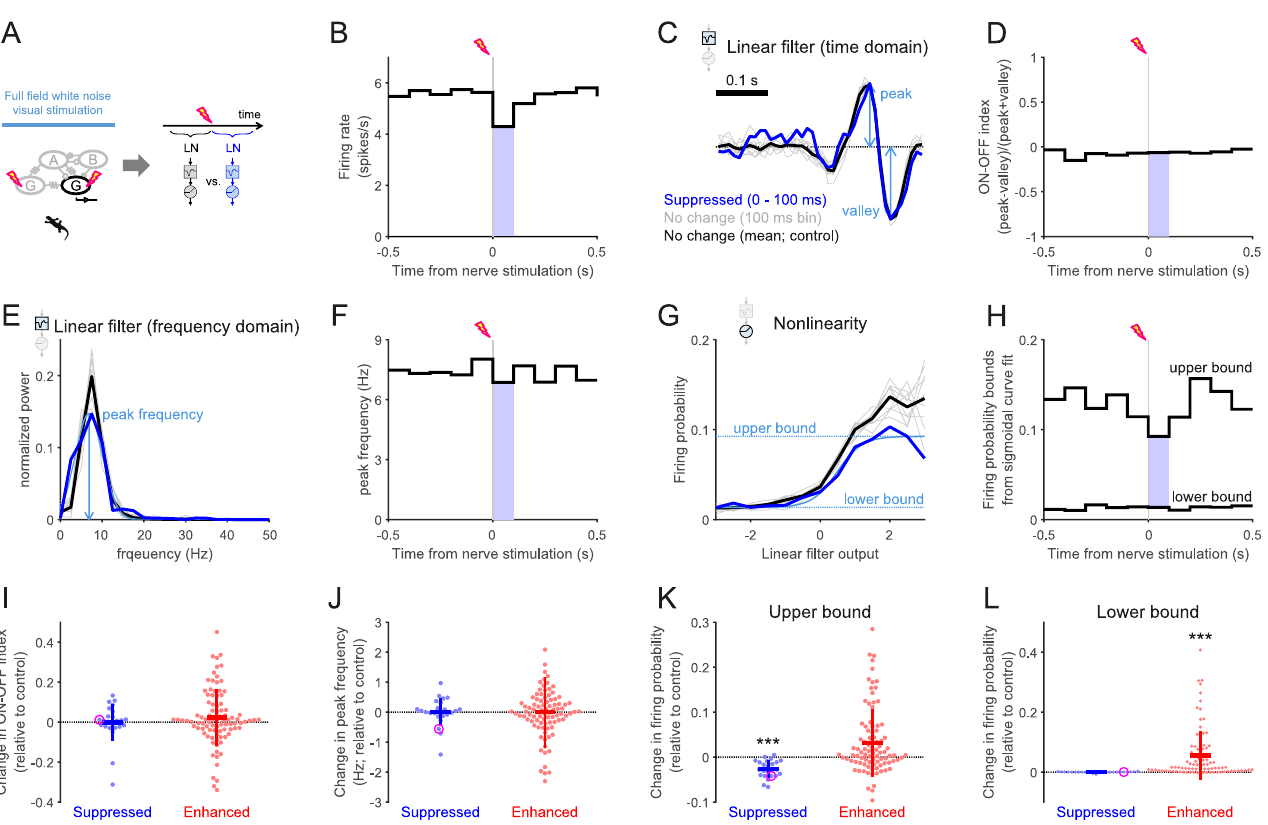
Fig 7. Negative feedback modulates the visual response gain but not the feature selectivity. (A) Schematic diagram of the experiment and analysis. Full-field white-noise visual stimuli were presented together with the optic nerve stimulation (inter-stimulus intervals, 1–1.5 s) to probe changes in the LN model parameters at different time windows from the nerve stimulation (see B–H for example). The linear filter represents the stimulus feature selectivity of a cell, while the static nonlinearity indicates the visual response gain. (B) PSTH of a representative salamander ganglion cell with respect to the optic nerve stimulation during the visual stimulus presentation. Blue-shaded bins (0–100 ms after the nerve shock) indicate those in which the firing rate was significantly lower than the baseline response of the cell (500 ms window before the nerve stimulation). (C) Linear filters of the example cell obtained by the reverse-correlation methods (i.e., spike-triggered average stimulus) using the spikes in different time bins from the PSTH (748–1037 spikes/bin; blue, 0–100 ms bin with significantly lower firing rates from B; gray, all the other 100 ms bins without significant firing rate changes; black, baseline). (D) Polarity of the linear filters (C) quantified by an ON-OFF index (i.e., the difference between the peak and valley values divided by the sum of the two; Eq (4) in Methods). (E) Normalized power spectral density of the linear filters in C. (F) Peak frequencies of the linear filters, estimated by fitting a gaussian curve to the power spectra in E. (G) Static nonlinearity of the example cell, computed for each corresponding linear filter at different time bins (Eq (5) in Methods). A sigmoid function (Eq (6) in Methods) was fitted to quantify the nonlinear profile (e.g., light blue for the suppressed period at 0–100 ms after the nerve shock, with the upper and lower bounds of the cell’s firing probability in dotted horizontal lines). (H) The upper and lower bound dynamics of the example cell’s firing probability with respect to the time from the nerve shock. The cell’s response gain (upper bound) became lower during the period of suppressed firing, while the stimulus feature selectivity remained unchanged (D and F). (I, J) Summary of the changes in the ON-OFF indices (I) and the spectral peak frequencies (J) between the periods with and without significant firing rate changes after the nerve stimulation (blue, decrease N = 25; red, increase N = 94; magenta, the representative cells in B–H). The horizontal and vertical lines represent the mean and standard deviation, respectively. On average there was no significant difference from the baseline across population ( p > 0.3 for both cases in I and J, sign-test). (K, L) Summary of the changes in the sigmoid function parameters fitted to the nonlinearity. The upper bounds (K) significantly decreased during the period of suppression (blue, p < 0.001, sign-test), but only marginally increased during the period of enhancement (red, p = 0.08). In contrast, the lower bounds (L) significantly increased during the enhancement ( p < 0.001) but remained the same during the suppression ( p >